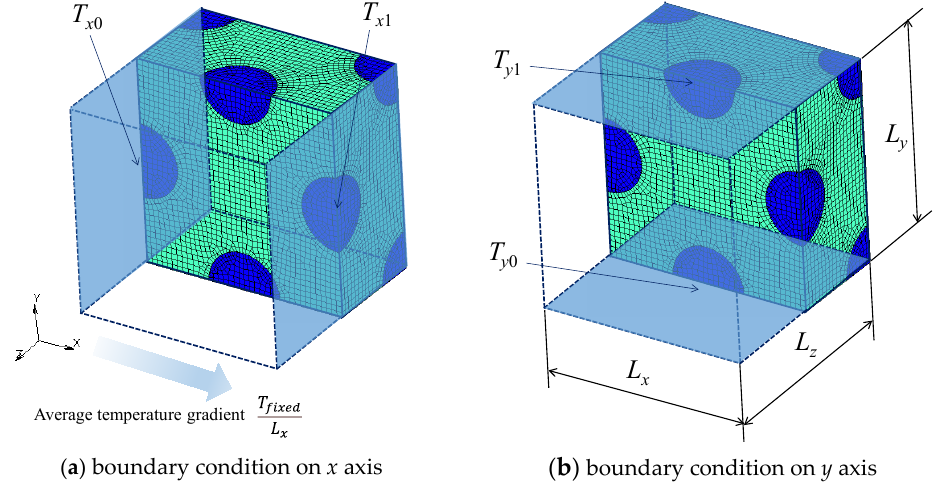
Figure 8. Boundary conditions of FEA models considering cyclic symmetricity.